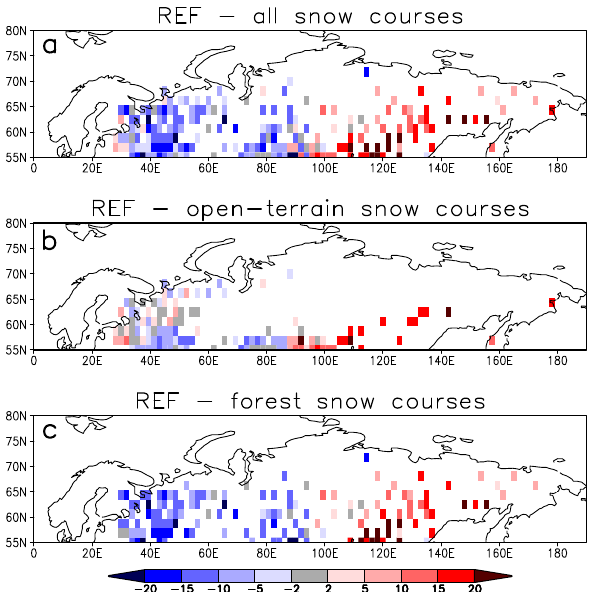
Figure 4. The difference in the average snow-off date for years 1979–2006 between the REF experiment and Russian snow course data for (a) all snow courses, (b) open-terrain snow courses, and (c) forest snow courses. Only those grid cells with snow-off data for at least 5 years are included.